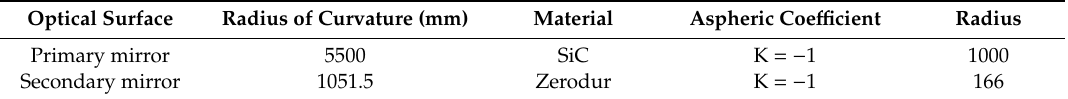
Table 4. Optical system parameters.